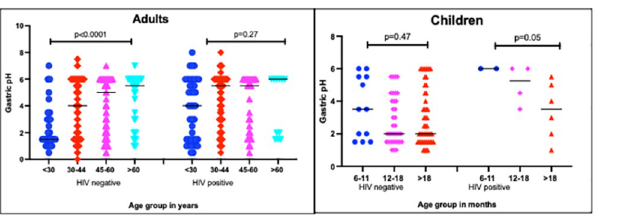
Fig 1. Gastric pH categorized by age group in HIV positive and negative adults and children. � Black horizonatal lines across each set of points represent the median �� The p-values reported were generated using the Kruskal-Wallis test evaluating association between gastric pH and the respective age groups.